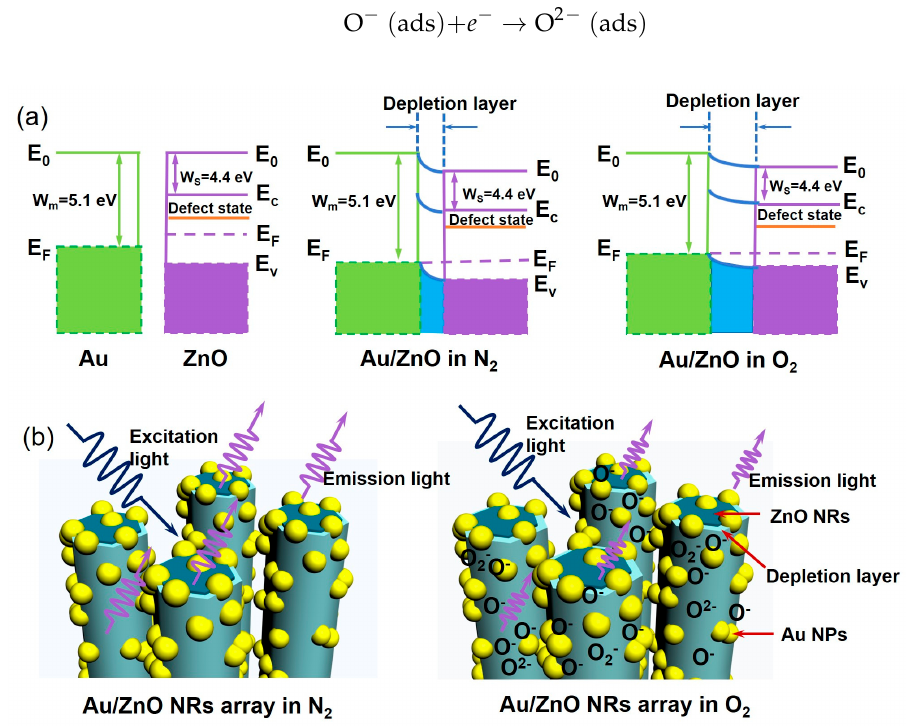
Figure 9. ( a ) Energy band and ( b ) fluorescence detection illustration of oxygen-sensing mechanism of Au/ZnO NRs.